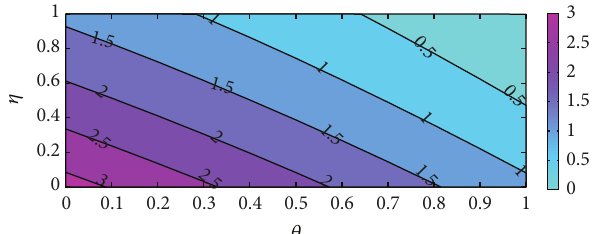
Figure 3: Simulations of model system (5) showing the contour plots of 𝑅 𝑎𝑐 as a function of the modification parameter (𝜂) and the proportion of individuals who are adhering to the HSV-2 antiviral treatment (𝜃)